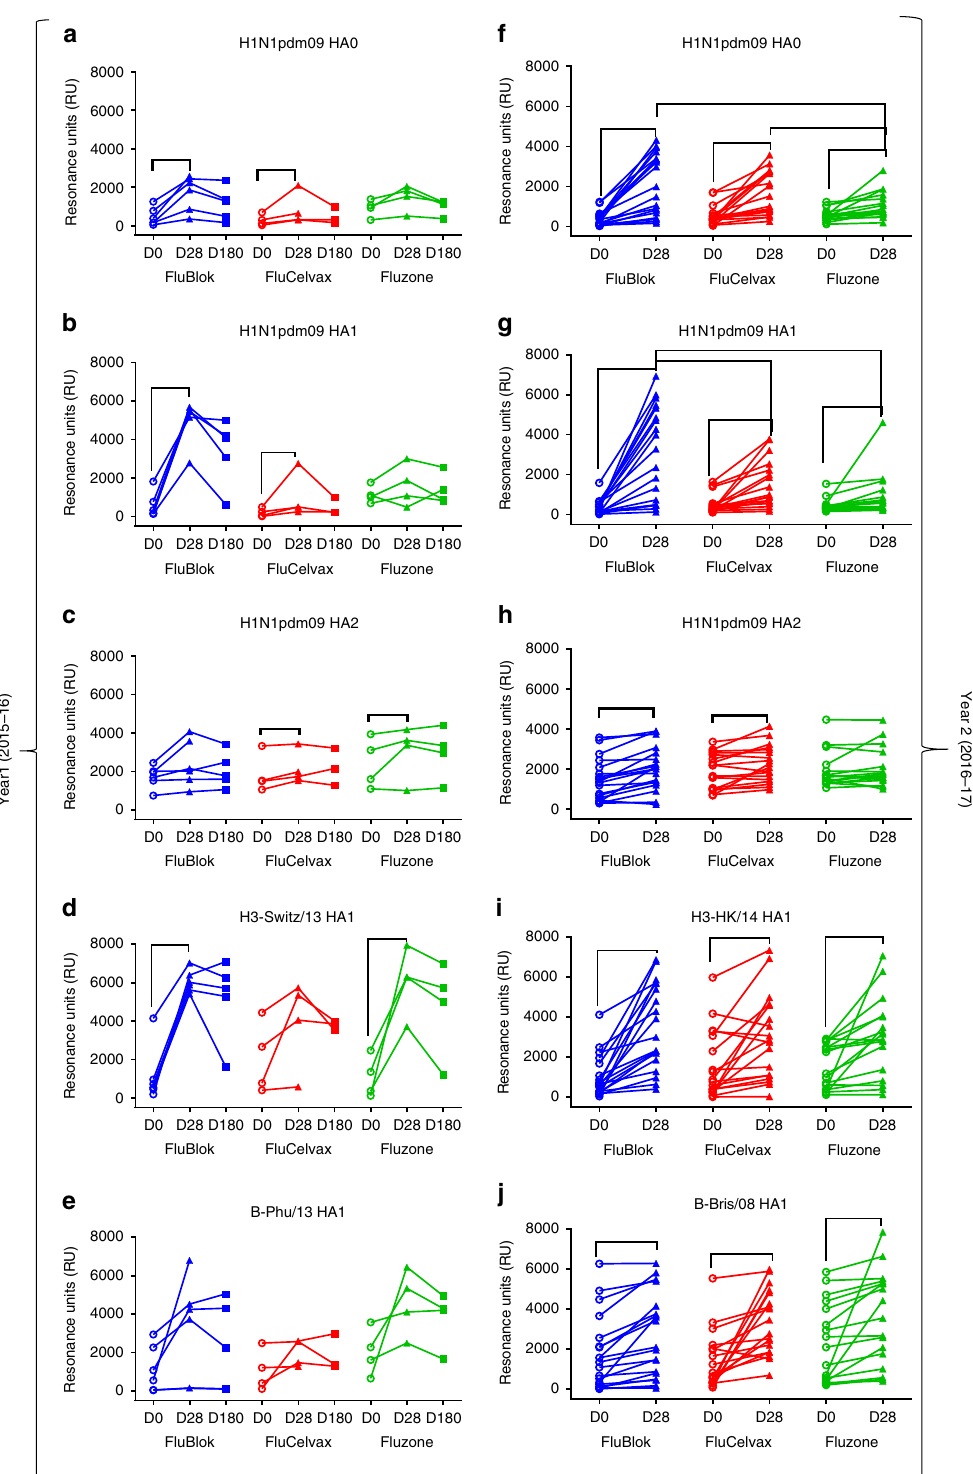
Fig. 2 Post-vaccination sera binding to native HA0, HA1, and HA2 domains. a – j Steady-state equilibrium analysis of human vaccine sera pre-vaccination (D0) and post-vaccination (D28) against properly folded homologous H1N1pdm09 HA0 ( a , f ), HA1 ( b , g ), and HA2 ( c , h ) domains, and H3N2 HA1 ( d , i ), and B-HA1 ( e , j ) are measured using SPR. Recombinant HA0, HA1, and HA2 domains are immobilized on a sensor chip through the free amine group. Binding of the polyclonal serum antibodies to the immobilized protein is shown as resonance unit (RU) values for individual subjects receiving FluBlok (in blue), FluCelvax (in red), and Fluzone (in green) for each subject (excluding repeat vaccinators) in year 1 (2015 – 2016; D0, D28, and D180; a – e ) and year 2 (2016 – 2017; D0 and D28; f – j ) of the study. For Day 28 post-vaccination resonance units (RU), and fold change from Day 0, an ANCOVA model was used for comparison between the vaccine groups, adjusted for gender, age, and baseline (Day 0) values (Supplementary Tables 4 and 5). Statistically signi fi cant differences between groups and pairs are indicated by horizontal bars. Source data are provided as a Source Data fi